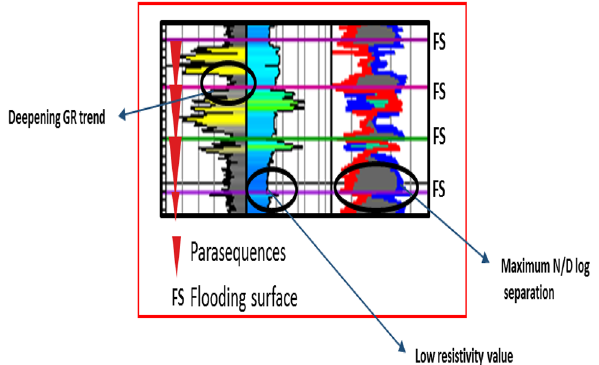
Fig. 8 Identification of flooding surfaces used to build sequence stratigraphic